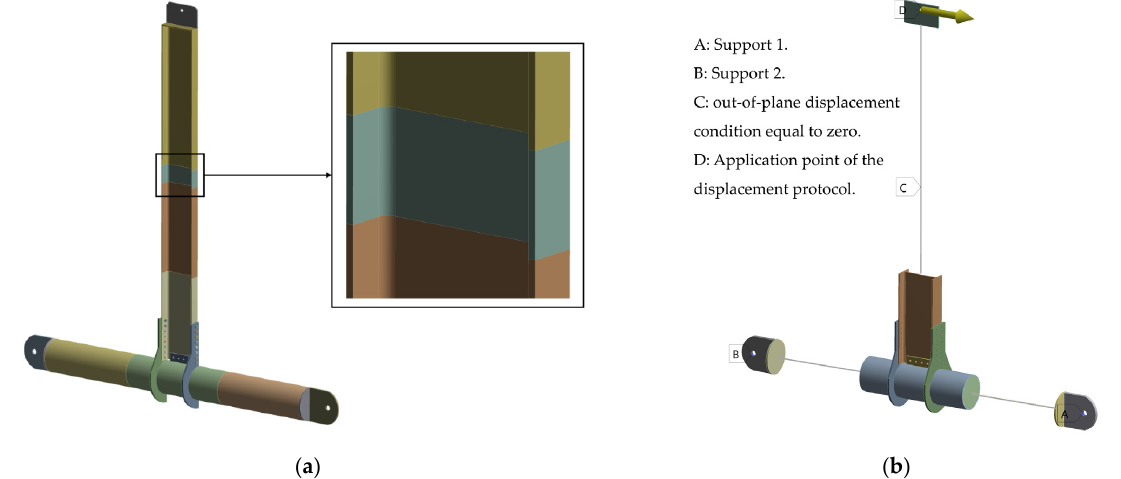
Figure 7. ( a ) Applied condition for the first simplification of the model; ( b ) Model simplification using SOLID186, BEAM 188 and MPC184 elements. The boundary conditions are also shown.